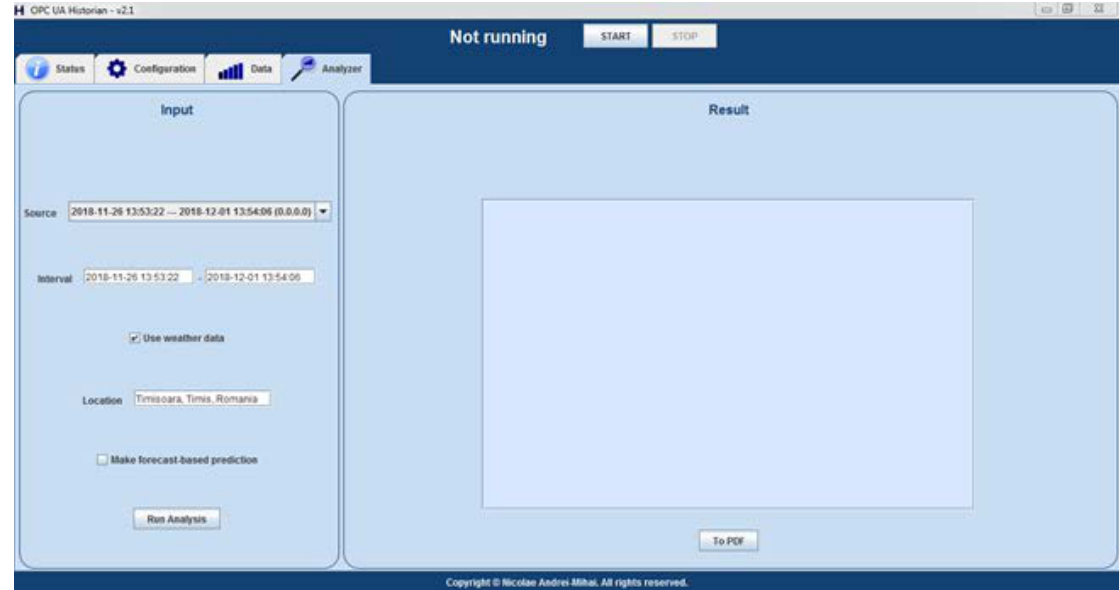
Figure 2. The new graphical user interface (GUI) elements of the Historian application.